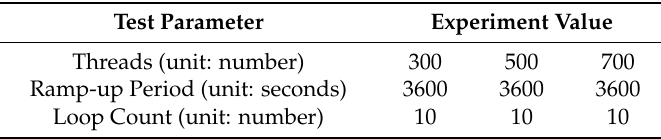
Table 2. Experiment parameters for performance testing.